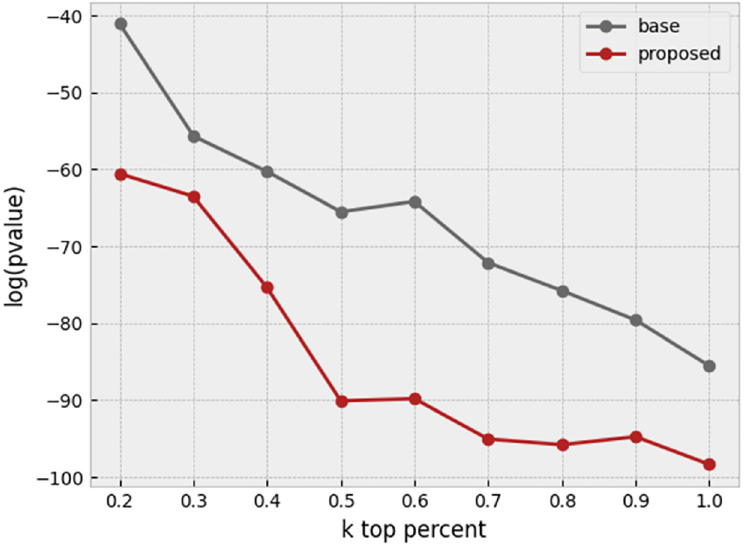
Fig 16. P-value comparison between base profiles and our proposed enhanced profiles in different k